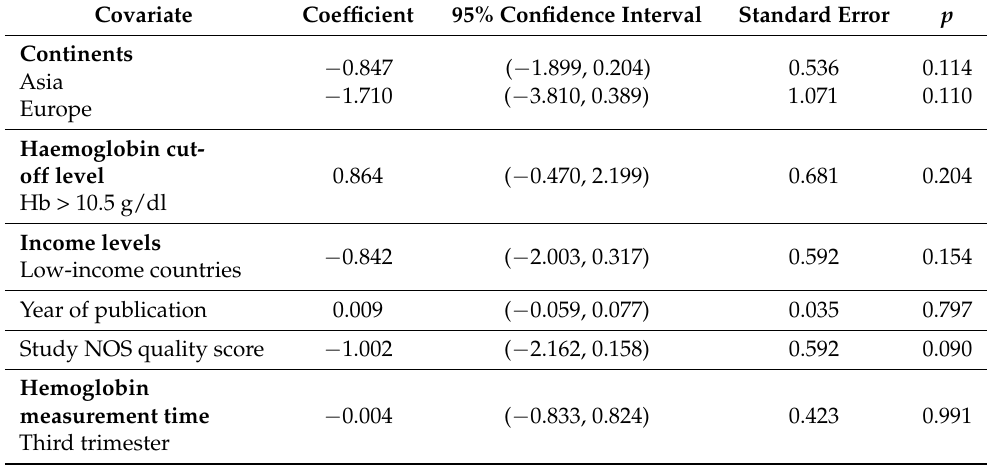
Table 2. Meta-regression analysis of the factors associated with anaemia and caesarean